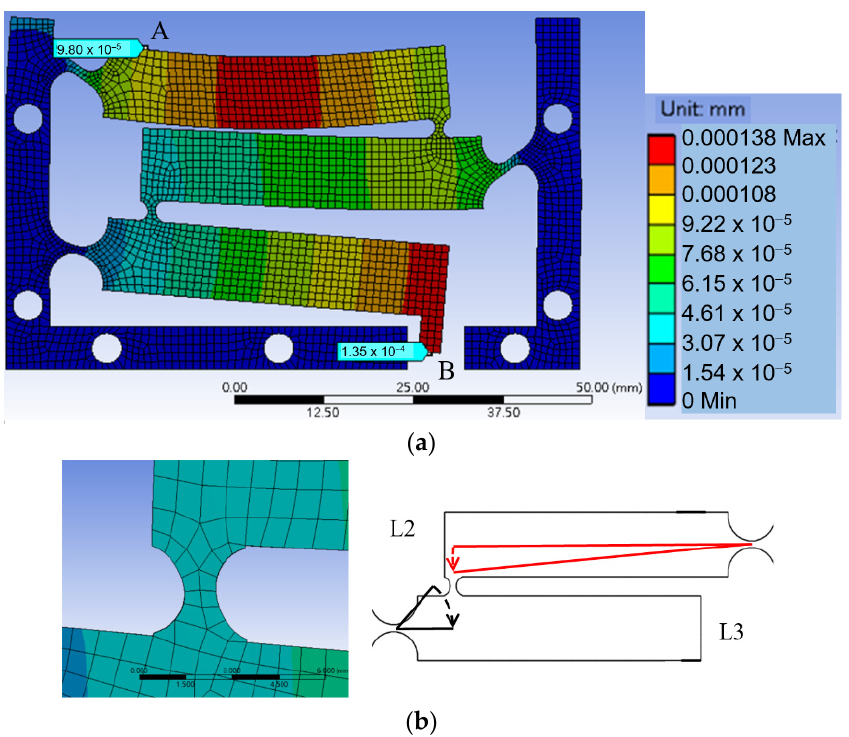
Figure 3. ( a ) is a total deformation graph of the structure when a force of 1 N is applied downward at contact place A; ( b ) is a close-up view of joint CF23 and exaggerated motion analysis between L2 and L3.